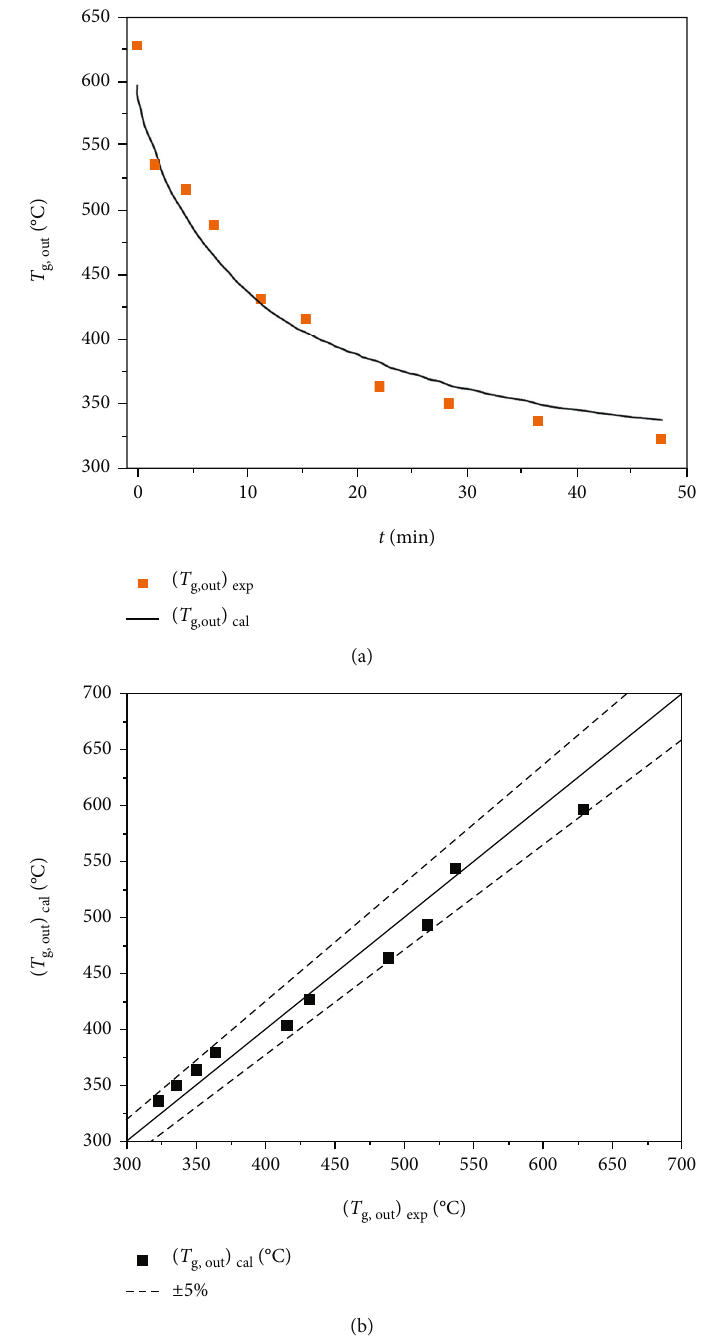
Figure 7: Veri fi cation of the numerical model: (a) change of the calculated value and measured value of the gas outlet temperature T with time t ; (b) comparison between the calculated value ð T